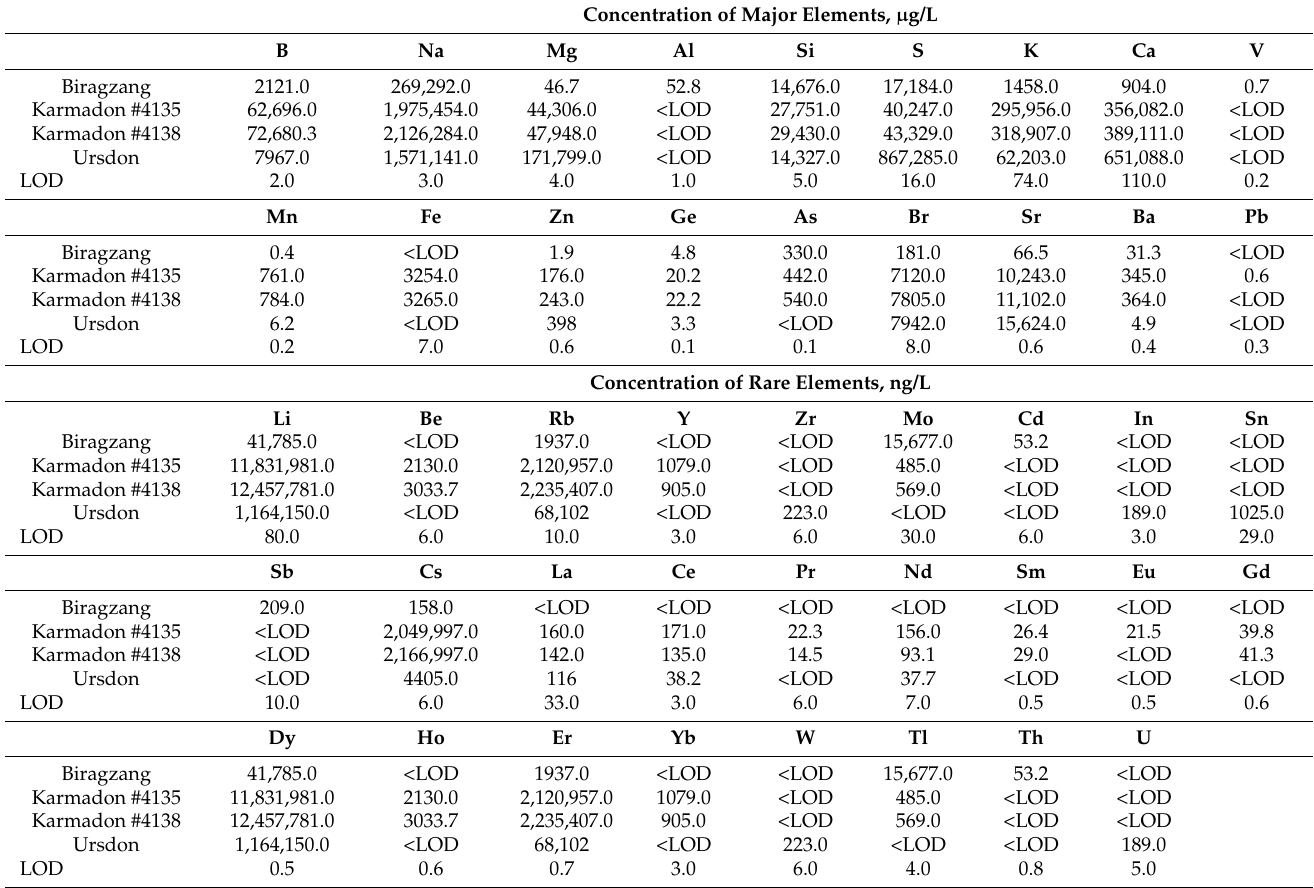
Table 2. Chemical composition of North Ossetian thermal water